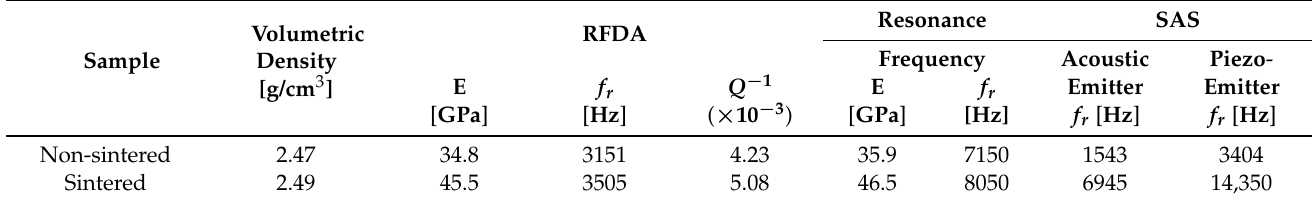
Table 2. Parameters of the unloaded material determined by the Resonance Frequency and Damping Analyzer (RFDA), the resonance frequency technique and the Self-Excited Acoustical System